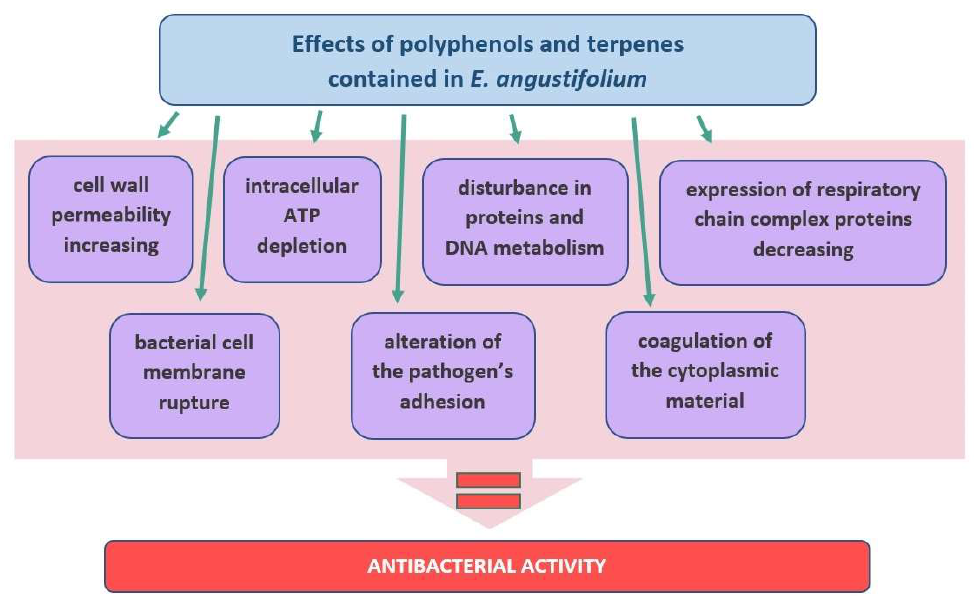
Figure 7. A diagram showing schematically the mechanism of antibacterial activity of the ingredients contained in E. angustifolium.